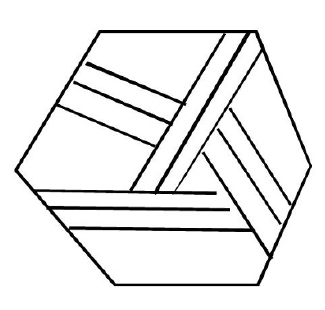
Figure 4. Schematic representation of bainite laths in the frame of the parent austenite grain.